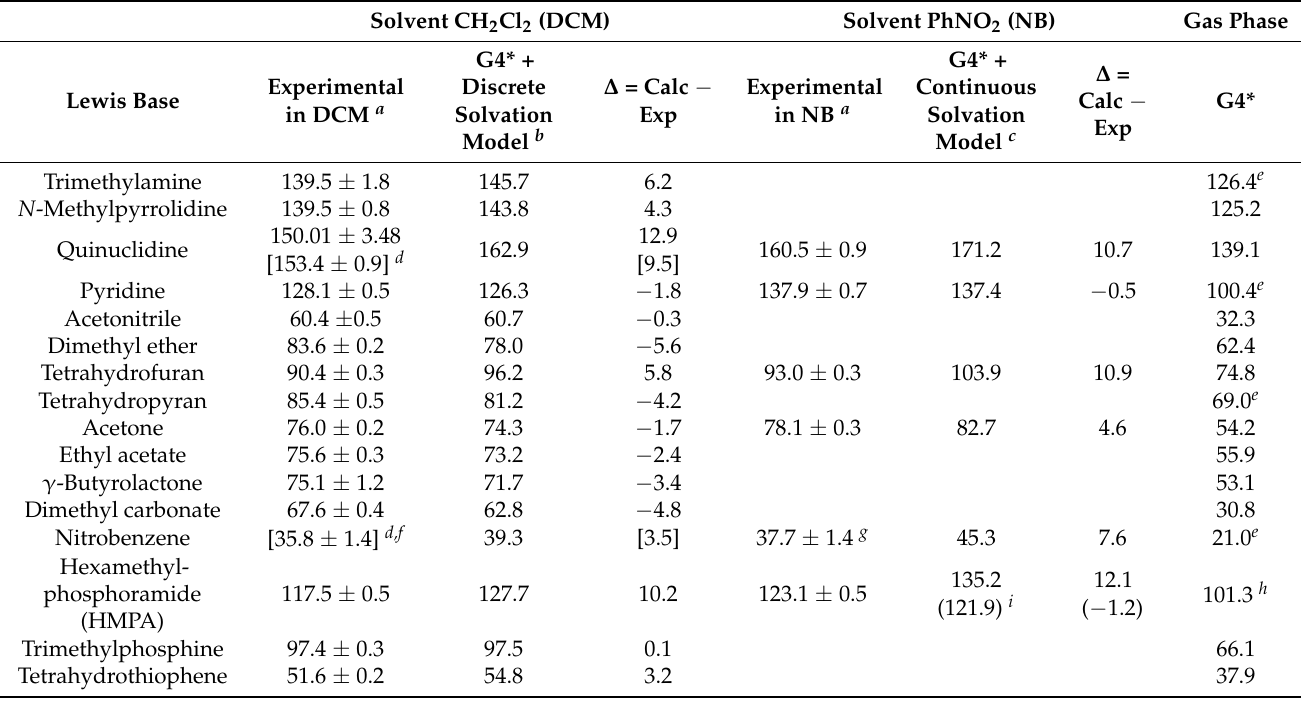
Table 2. Experimental and calculated enthalpies of adduct formation ( − ∆ H , kJ · mol − 1 at 298 K)) between BF 3 and Lewis bases in dichloromethane (DCM) and nitrobenzene (NB) solutions (reaction (2a) and (2b)); kJ · mol − 1 ). The signification of uncertainties on experimental enthalpies is discussed in the text. G4*-calculated gas-phase enthalpies are listed in the last column.